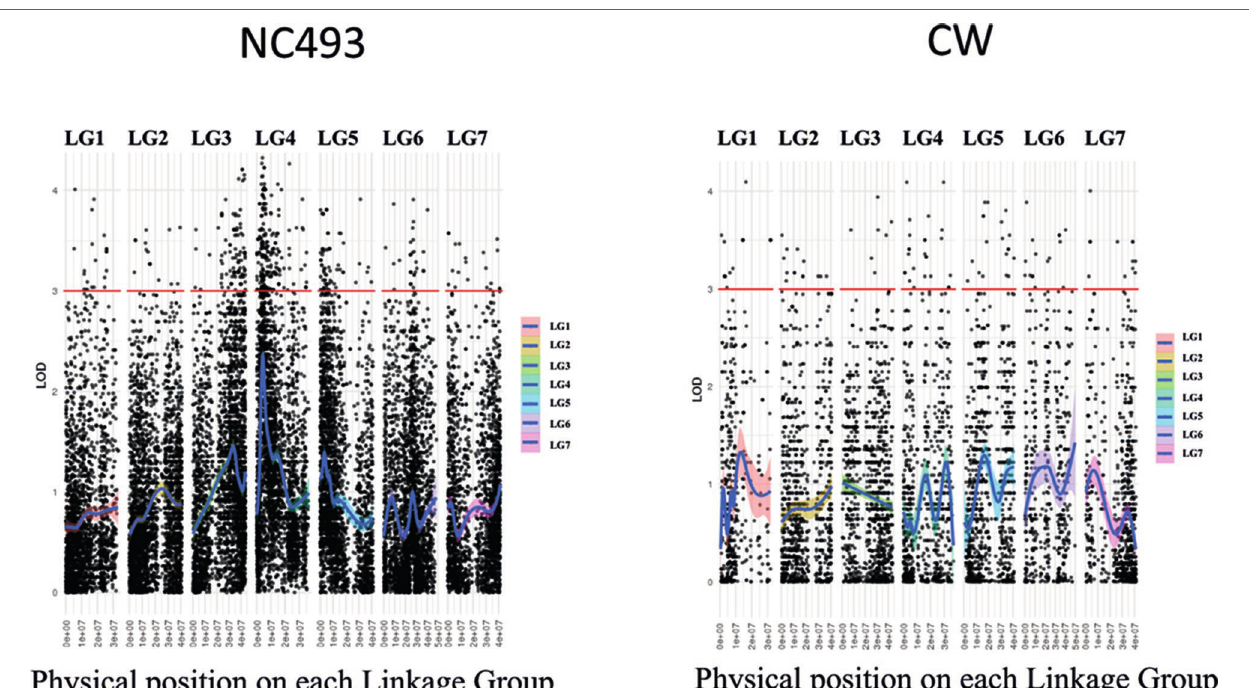
FIGURE 3 | Manhattan plot showing genomic regions associated with Annual-Fruiting (AF) in Rubus idaeus . Genotyping by sequencing (GBS)-based single- nucleotide polymorphism (SNP) markers significantly linked to the trait was identified by the chi-square test using markers that were heterozygous in NC493 (AF) and homozygous in ‘Chilliwack’ (Biennial-Fruiting, BF). The x-axis shows LOD scores, and the y-axis indicates the physical position of markers (black points) in the genome divided into seven linkage groups (LGs). The names and the physical position of the markers associated with control of AF are given in Supplementary Table S2 . CW =